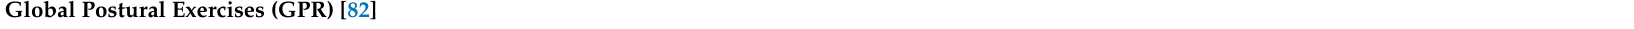
Table 4. Details of the progression of the global postural exercises (global postural